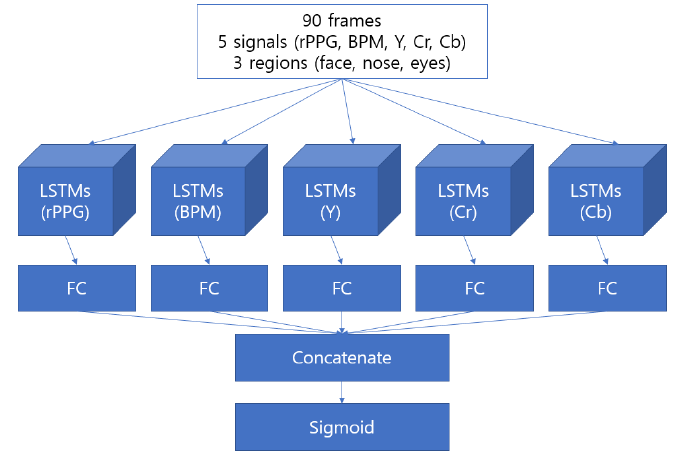
Figure 8. LSTM-based model structure with every method implemented.